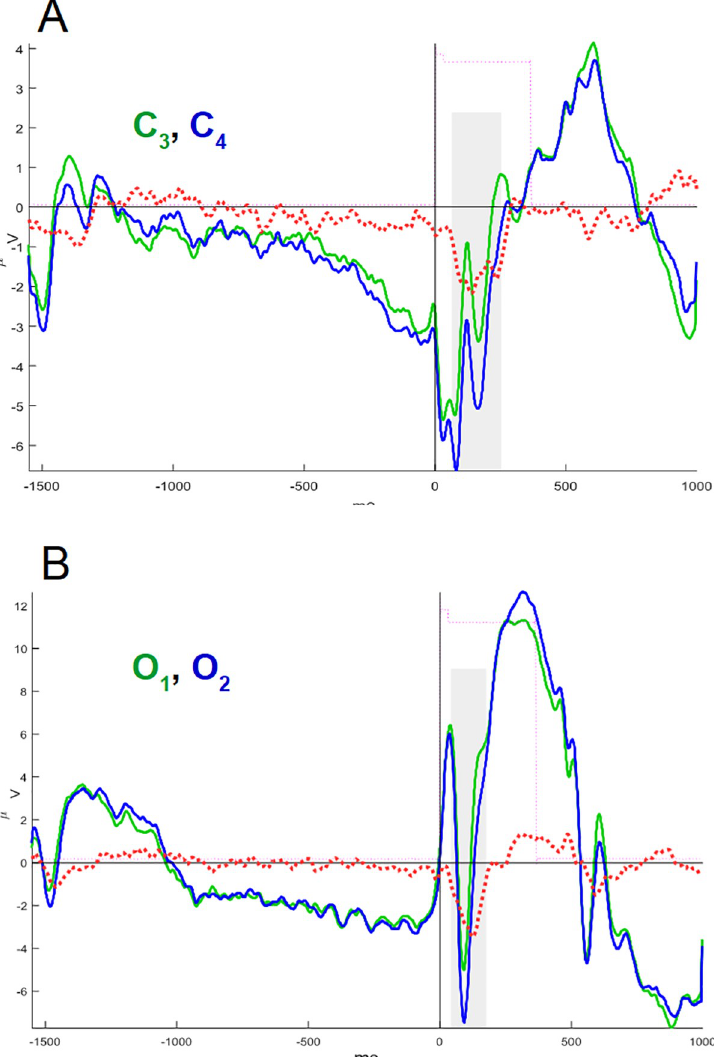
Fig 7. ANT-related potentials of central and occipital channels and their differences in the ADHD group. (A) ANT-related potentials in the central region. Superimposed potentials from the left (C3, green) and right (C4, blue) leads, and the arithmetic difference between them, revealing the rightward asymmetry (C4 –C3, dashed red line). (B) The same for potentials in occipital region from the left (O1) (green) and right (O2) (blue) leads. Amplitudes in μ V.